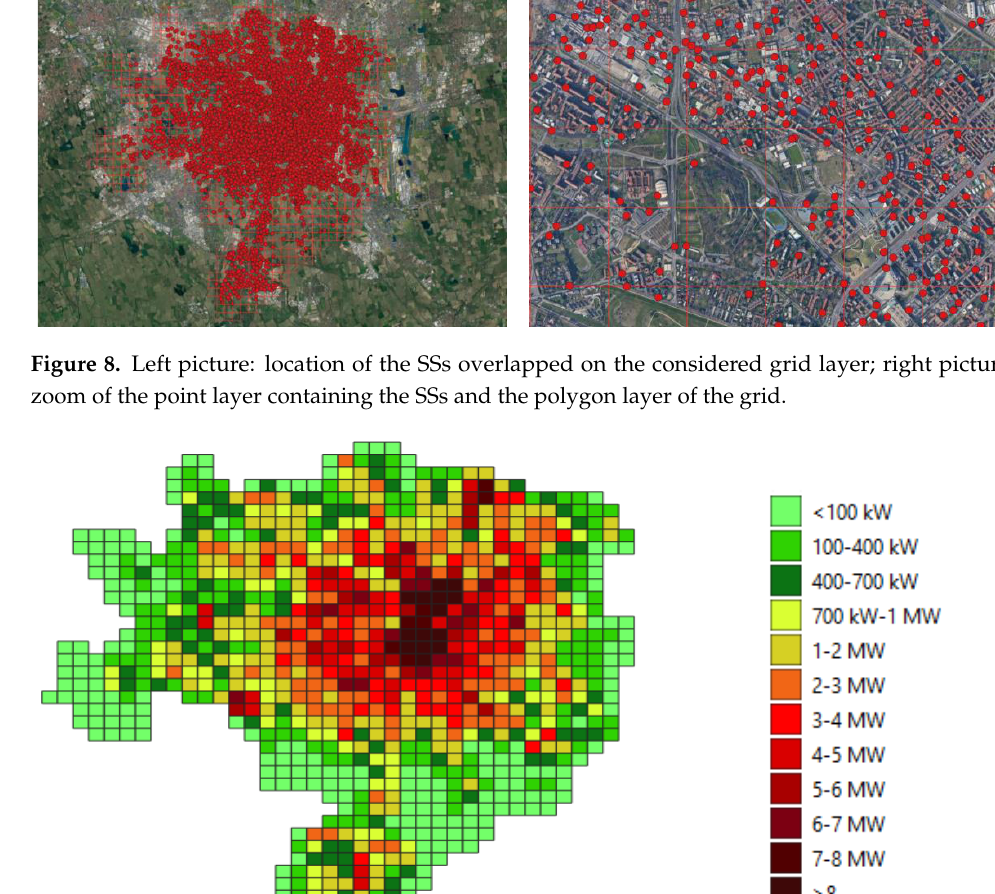
Figure 8. Left picture: location of the SSs overlapped on the considered grid layer; right picture: zoom of the point layer containing the SSs and the polygon layer of the grid.